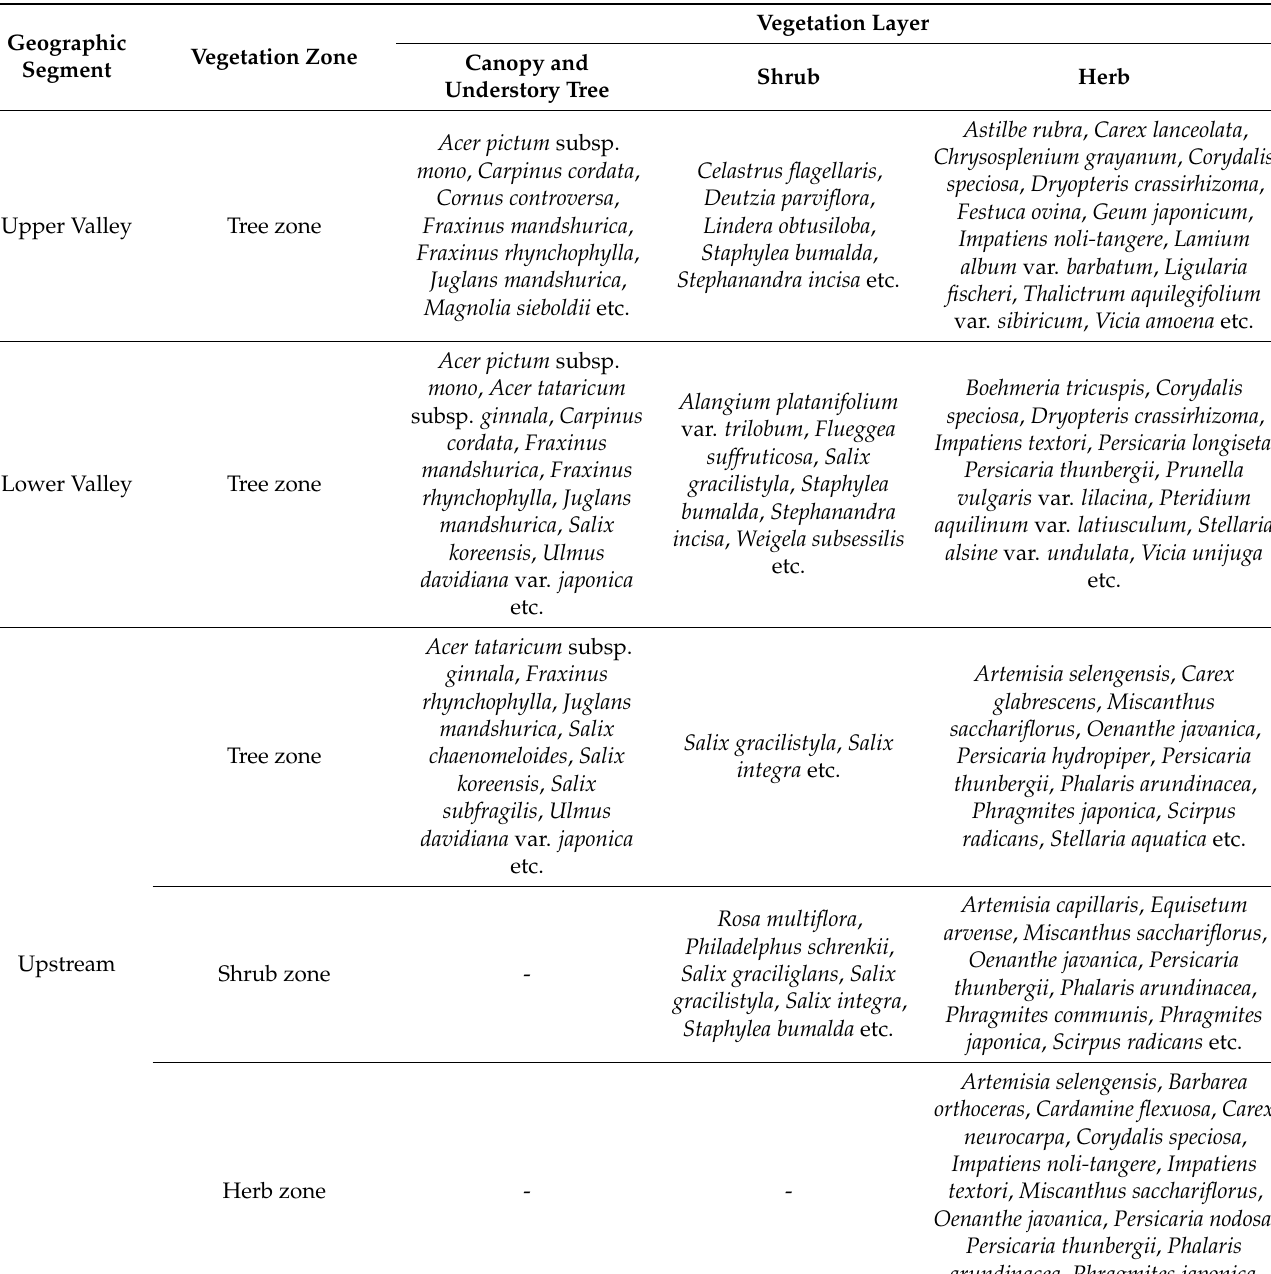
Table 5. Species composition by horizontal zone of vegetation to be introduced for restoration. This reference information was prepared by incorporating riparian vegetation data collected from the river reaches evaluated as ‘very good’ grade in the diagnostic assessment for the naturalness of rivers executed throughout the whole national territory of South